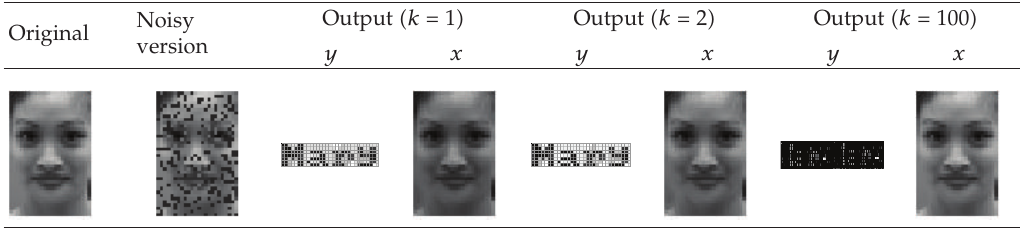
Table 1: Network recall for a noisy